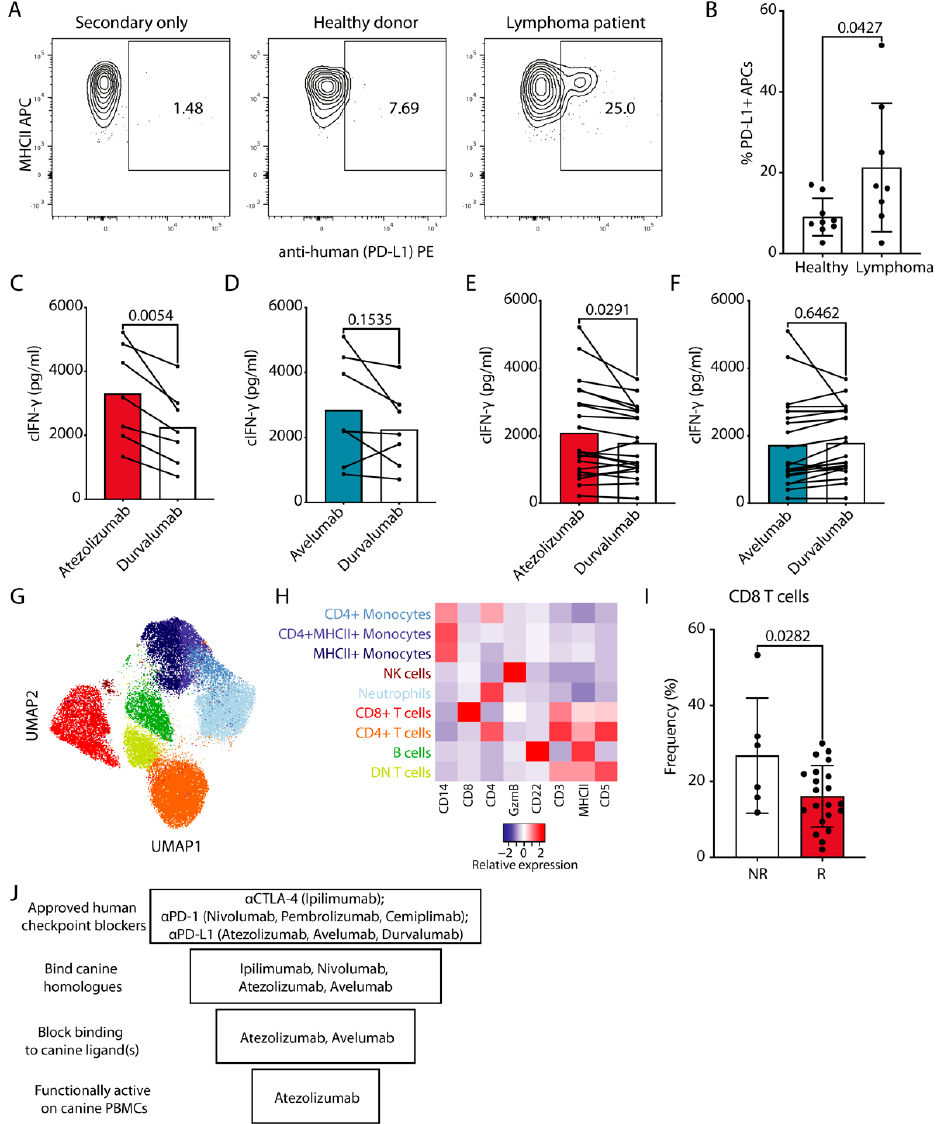
Figure 4. Functional effects of cPD-1/L1 blockade on cIFN- γ production by cancer patient derived cPBMCs. ( A ) Representative staining for PD-L1 on CD5 − CD14 − MHCII+ APCs with atezolizumab, which was subsequently detected with PE labeled anti-human Fc antibody. ( B ) Pooled data from two independent experiments with each point representing a healthy donor or a lymphoma patient (Mean, SEM, Unpaired Student’s t test with p value indicated on the plot). ( C – F ) cPBMCs from cancer patients ( n = 27, Table 3) were stimulated and evaluated as in Figure 3D–F. ( C , D ) Lymphoma patients, ( E , F ) non-lymphoma cancer patients (Table 3). Pooled data from three independent experiments (Paired Student’s t test with p values indicated on the plots). ( G , H ) Cancer patient PBMC samples classified as non-responders (NR, n = 6) or responders (R, n = 19) as well as healthy donor PBMC samples classified as responders (HD, n = 11) (1500 cells/sample) were flow cytometrically analyzed and concatenated; all lymphomas were excluded. ( G ) UMAP clustering analysis with different identified populations colored according to the cluster they were assigned to using the FlowSOM algorithm and manual annotation. ( H ) The heat map represents the normalized median fluorescence intensity (MFI) for respective markers within each cellular population for the nine clusters from concatenated data and was used to annotate the clusters in G. ( I ) Bar graph shows the frequency of CD8+ T cells in the PBMCs of NR vs. R, only T cell lymphomas were excluded. Each point represents a patient (Mean, SEM, Unpaired Student’s t test with p value indicated on the plot). ( J ) Schematic summary of the evaluation of the effect of human ICIs for